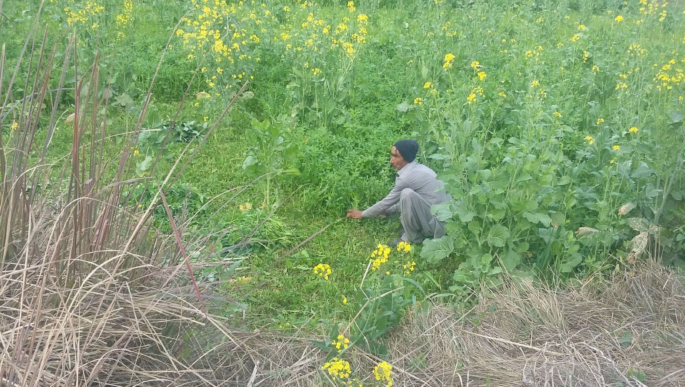
Figure 14. A man cutting crop on daily wages in SW, District Layyah.